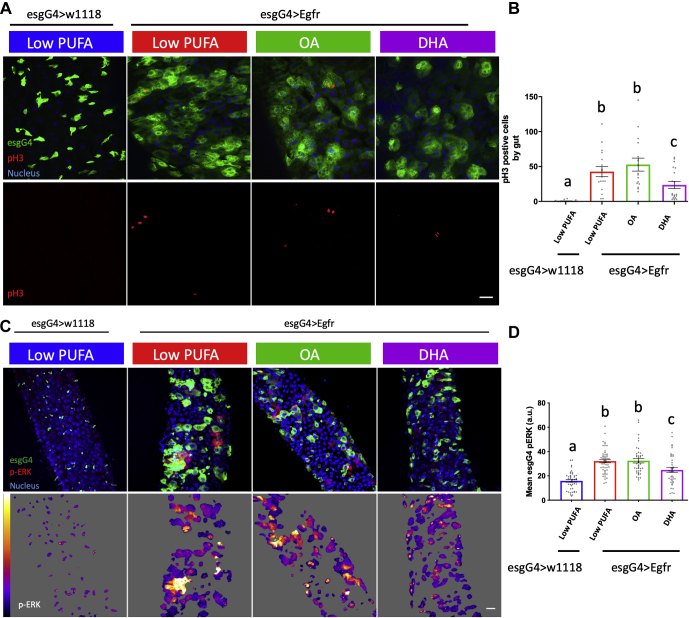
Dietary DHA reduces EGFR overexpression–driven proliferation and ERK activation. Adult Drosophila were placed on control (PUFA Free) or OA- or DHA-enriched diets for 5 days at 18°C (permissive temperature) before switching to 29°C for 2 days to induce EGFR overexpression in gut esgG4 cells. A: Representative merged and pH3 images. Scale bar, 20 μm. B: Quantitative analysis of proliferation as assessed by pH3 at 48 h post EGFR induction. Data represent mean ± SE from 16–21 guts from three independent experiments. C: Representative merged maximum image projection and masked esgG4 stem cell pERK. Scale bar, 20 μm. Quantitative analysis of (D) mean pERK in esgG4 cells per field of view (FOV) from flies fed the experimental diets. Data represent mean ± SE from 39–51 FOV from 30 guts from three independent experiments. Statistical significance between treatments as indicated by uncommon letters (B, P < 0.05; D, P < 0.01) was determined using one-way ANOVA and uncorrected Fisher's LSD tests.